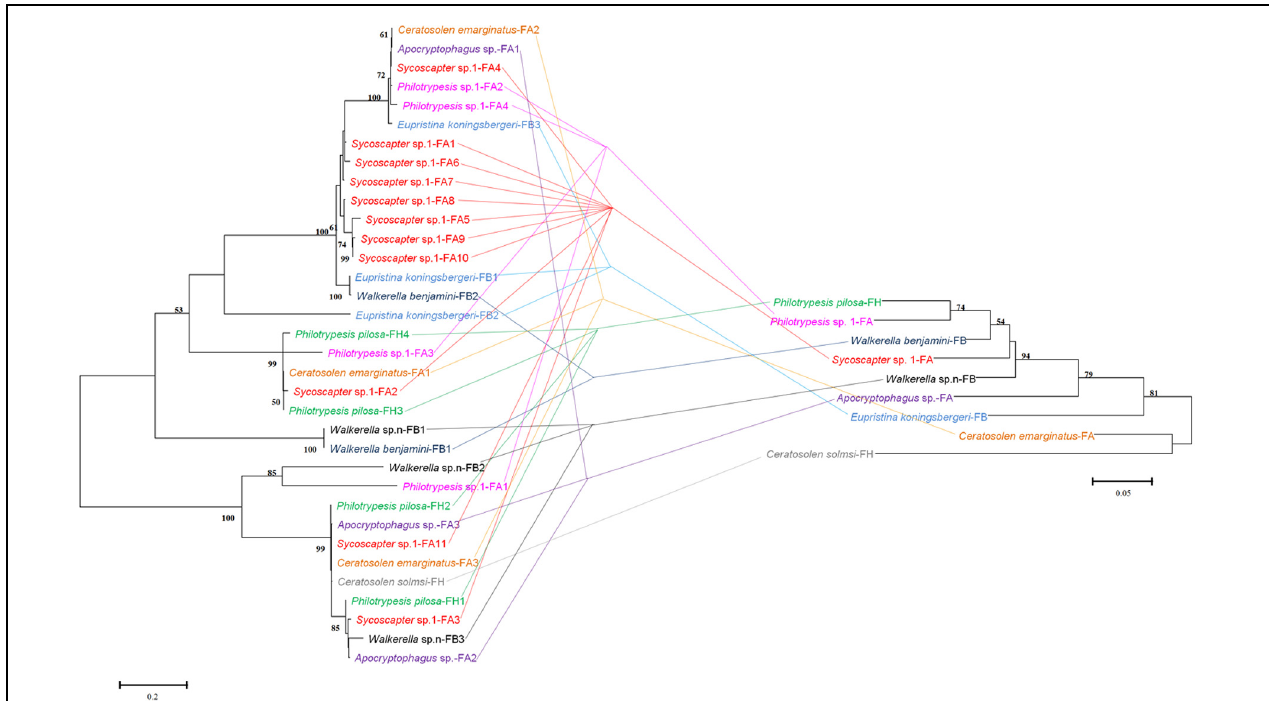
FIGURE 5 | Comparison between phylogenies of Wolbachia based on the wsp sequence (left) and fig wasps based on the COI sequence (right). Samples tested in our survey are named by insect host name followed by the fig name (FA: Ficus auriculata, FH: Ficus hispida , FB: Ficus benjamina ) and haplotype